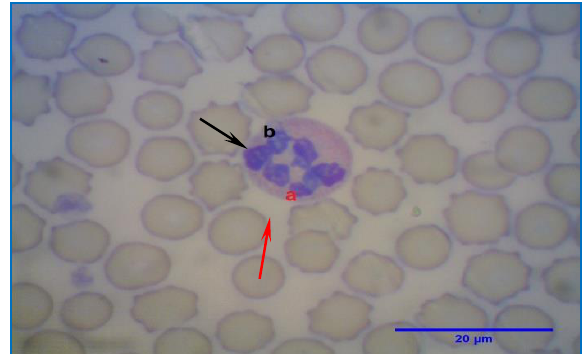
Figure, 3: Neutrophil with six lobes of segmented nucleus (100x × 1.3 megapixels).